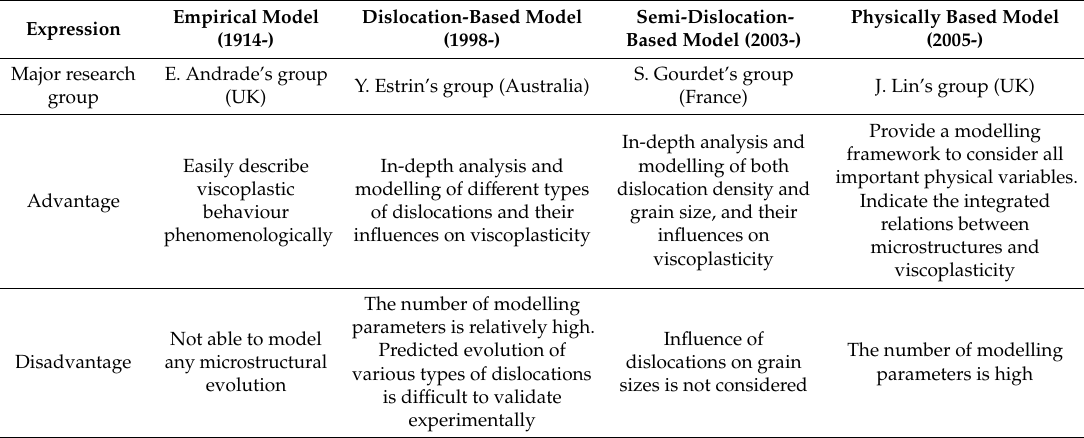
Table 1. Summary and comparison of di ff erent kinds of modelling